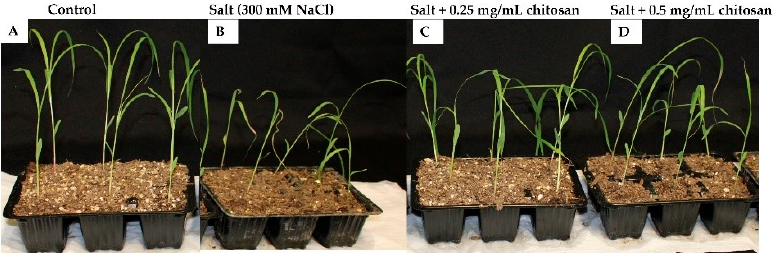
Figure 1. The phenotypic analysis of the positive effects of chitosan on the growth of sorghum under salt stress. Plants grown under ( A ) control, 0 mM NaCl; ( B ) salt: 300 mM NaCl; ( C ) salt + 0.25 mg/mL chitosan; and ( D ) salt + 0.5 mg/mL chitosan.